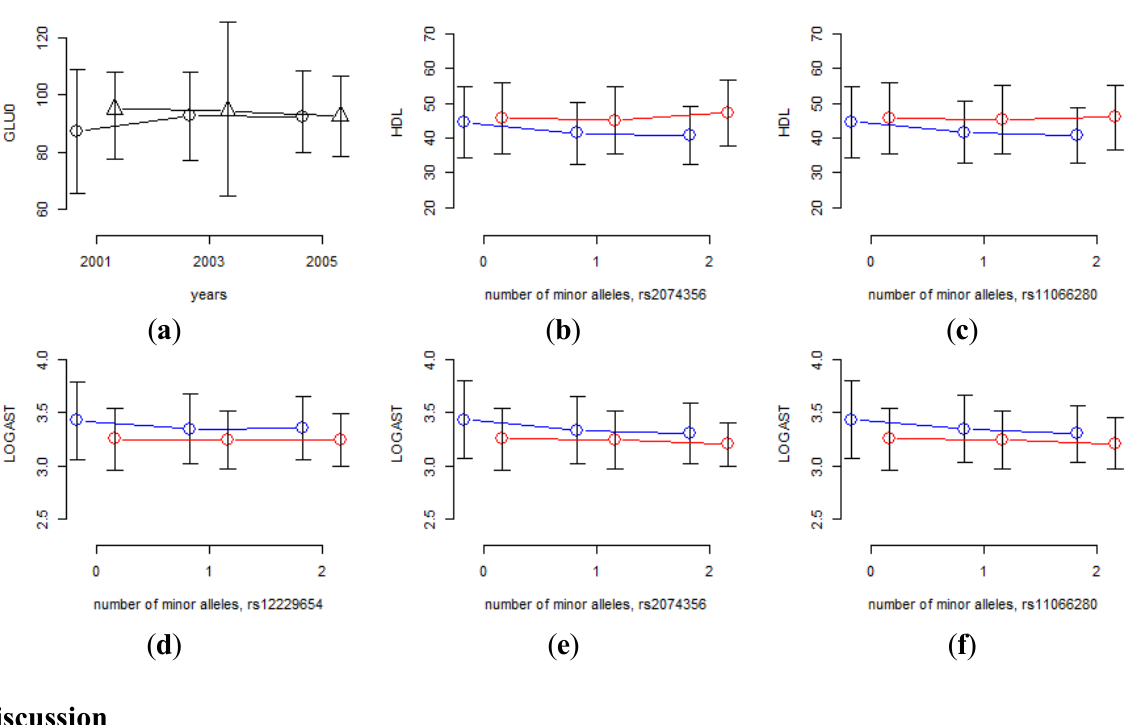
Figure 4. Interaction effects of SNPs with sex or time interval. ( a ) Mean of GLU0 at each time-point for each of two rs7197218 genotypes (circles indicate homozygous genotypes with no minor alleles, triangles indicate heterozygous genotypes); ( b-f ) phenotypic mean of each genotype for males and females (blue and red lines indicate male and female,